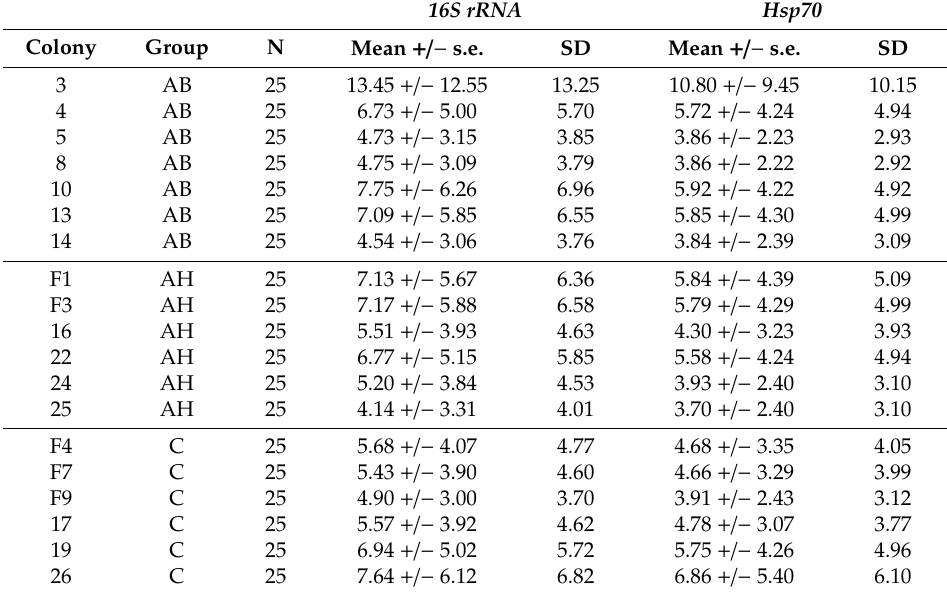
Table 2. Mean abundance of N. ceranae copies detected with the two qPCR methods in the samples collected pre-treatment from the experimental colonies. As data covered various orders of magnitude, for ease of reading, logarithmic representation was adopted. Standard error of means (s.e.) and standard deviations (SD) are shown also. 16S rRNA Hsp70 Colony Group N Mean +/ − s.e. SD Mean +/ − s.e.